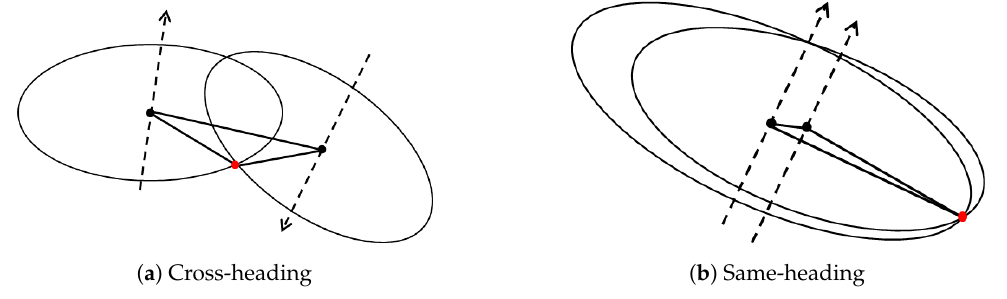
Figure 14. Localization of a point target (red dot) from ( a ) cross-heading and ( b ) same-heading satellite tracks. The satellites are shown by black dots; their trajectories are presented by dashed lines and the baselines are depicted by solid lines between the satellite positions. The black circles are defined by the range-Doppler equations and their intersection leads to the 3D position of the target